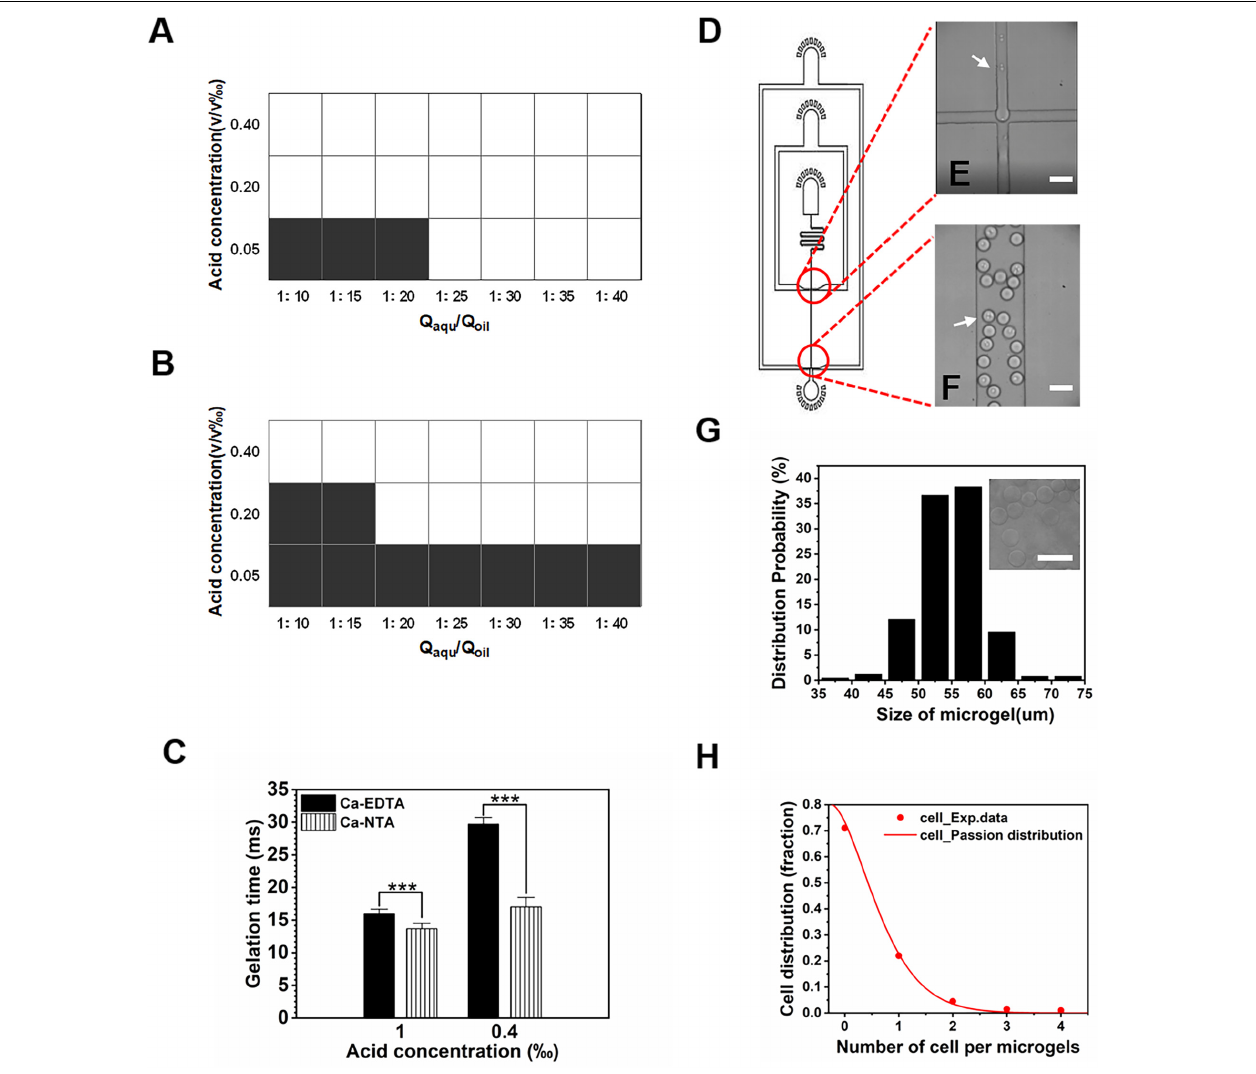
FIGURE 3 | Gelation triggered by different calcium complexes. (A,B) Effect of water–oil flow rate ratio (Q aqu /Q oil ) and acetic acid concentration on the formation of alginate microgels when (A) Ca-NTA and (B) Ca-EDTA were used as the crosslinker, respectively. White and black areas indicated complete crosslink and uncrosslink, respectively. If the gelation process can be achieved on-chip, solid-like hydrogel particles can be obtained. Otherwise, only liquid can be collected since the gelation of the droplets cannot be realized within the short time window, for which we considered them as uncrosslinked microgels. (C) Gelation time in different acid concentrations where Ca 2 + ions were chelated in NTA or EDTA. (D) AutoCAD design of the microfluidic device for cell encapsulation. (E,F) Microscopic images of microchannels (E) for formation of alginate cell-laden microgels (F) . White arrows indicate cells. (G,H) Effect of Ca-NTA on microgel size and cell distribution. (G) Size distribution of alginate microgels. (H) Cell distribution in the microgels follows the Poisson distribution. Scale bar is 100 µ m ( ***p <